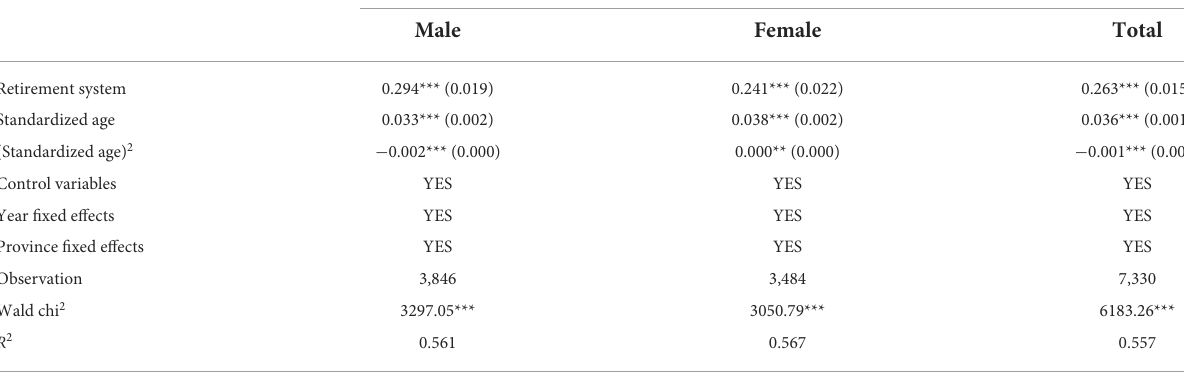
TABLE 2 Regression results from the first stage of the FRD.